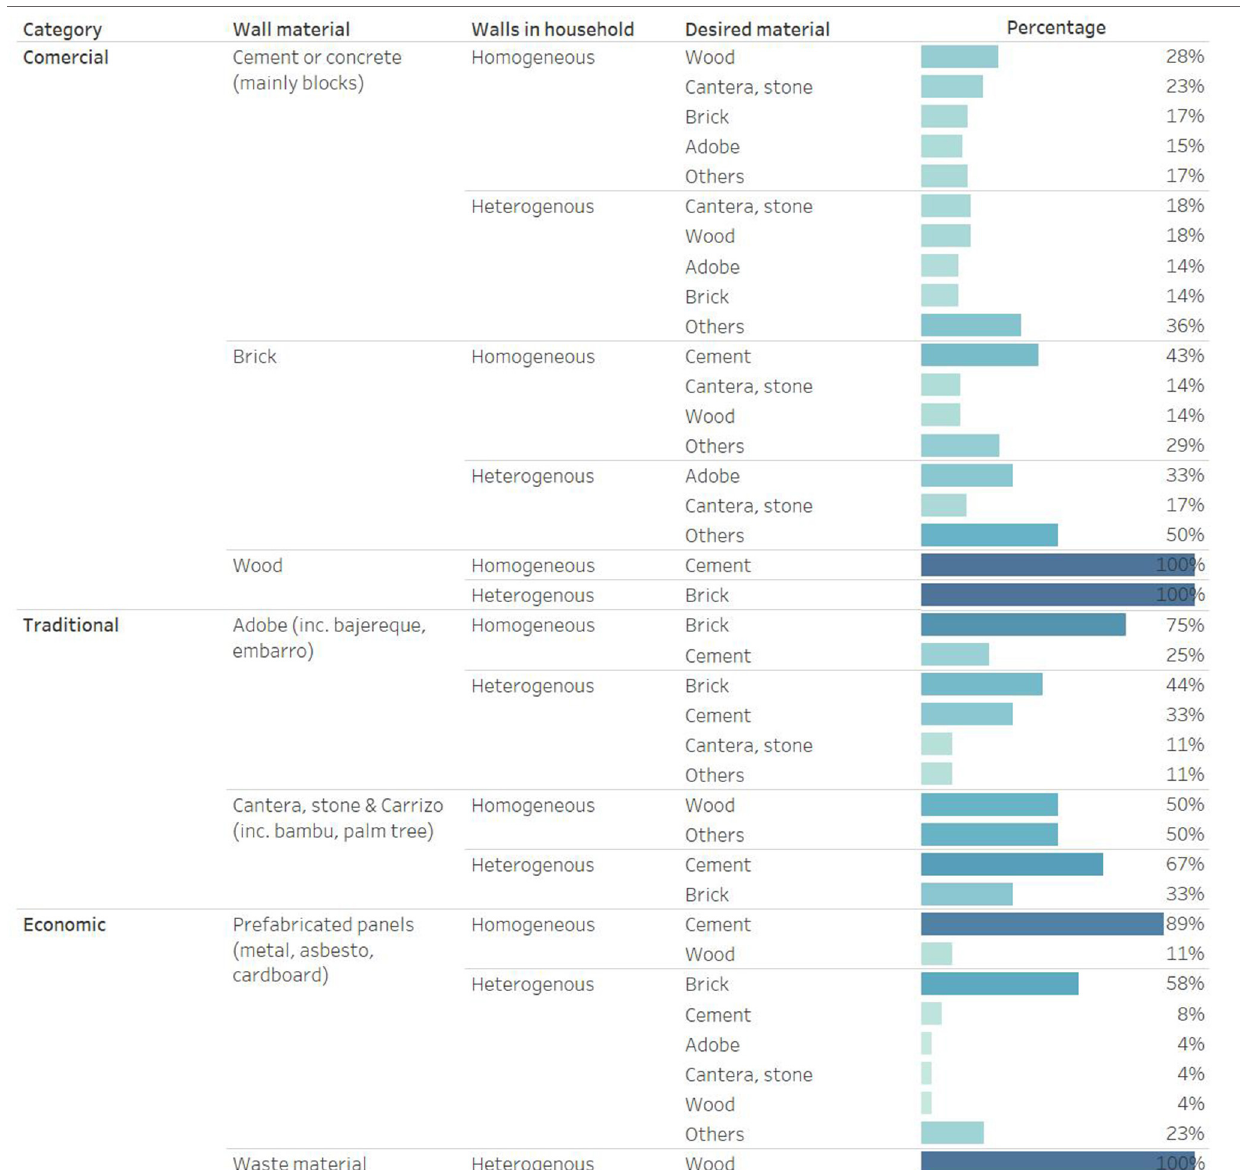
TABLE 7 | Wall materials and ideal types in ZMVO